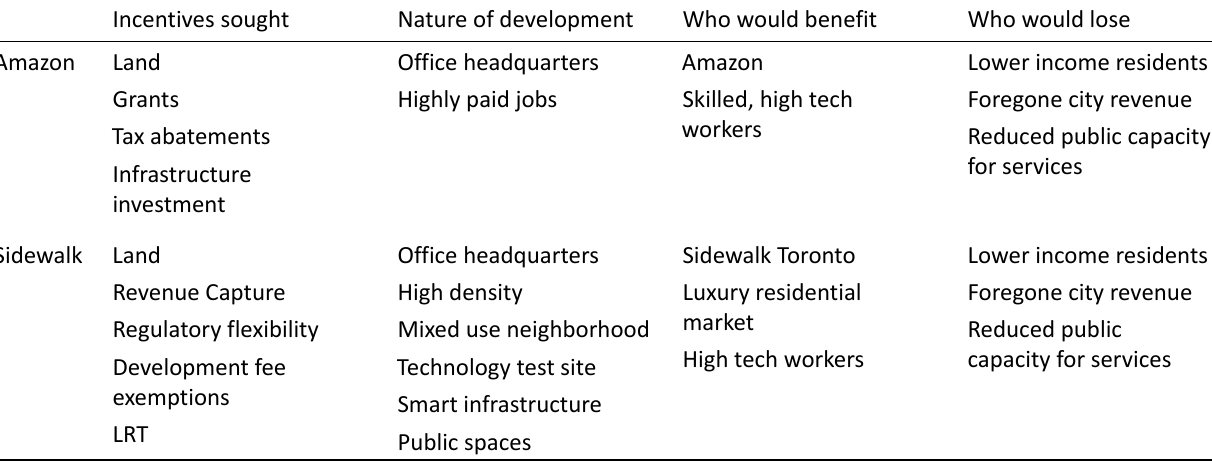
Table 3. Summary comparison of